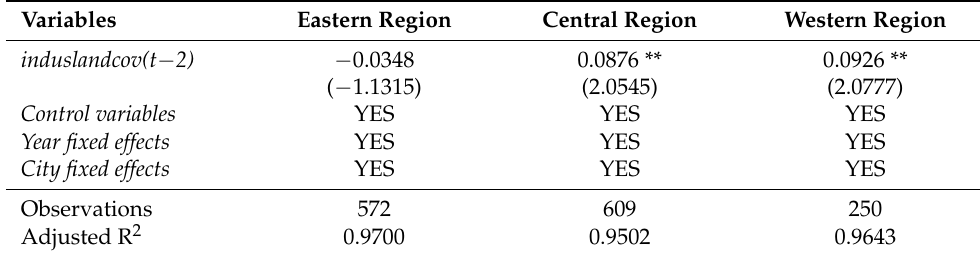
Table 6. Regional heterogeneity analysis.